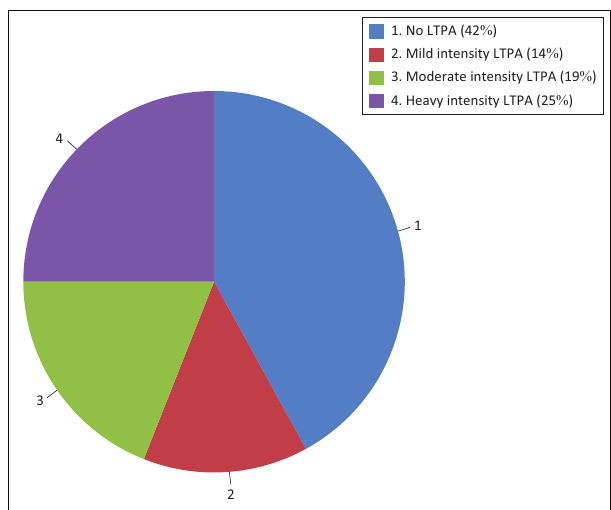
FIGURE 2: Participation in leisure-time physical activity by people with spinal cord injury using the leisure-time physical activity questionnaire for people with spinal cord injury.